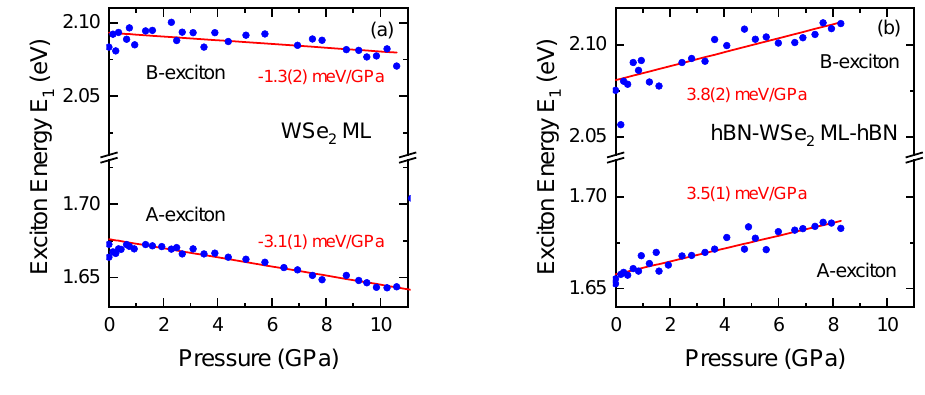
Figure 4: Ground state energy E 1 of the A and B-exciton as a function of pressure (a) for the bare WSe 2 ML and (b) for the hBN/WSe 2 -ML/hBN vdW heterostructure. Lines represent least-squares fits to the data points. Numbers in parentheses represent error